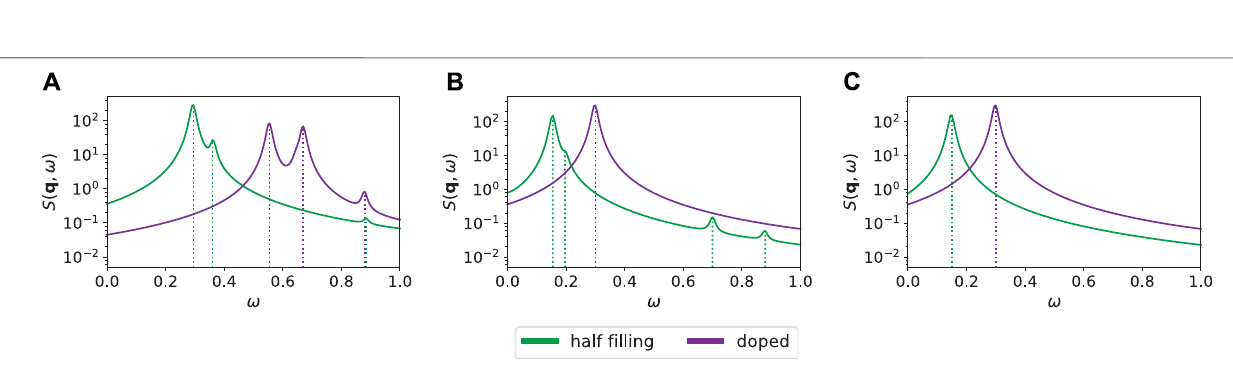
FIGURE 5 | Multiplet calculations for two-site, two-hole (solid, blue line) and two-site, three-hole (dashed, orange) NiO 2 clusters. The absorption energy is measured from the ground state of the two-site, two-hole calculation. Panel (A) shows the XAS spectra in x -polarization; and panel (B) shows the XAS spectra in z -polarization.